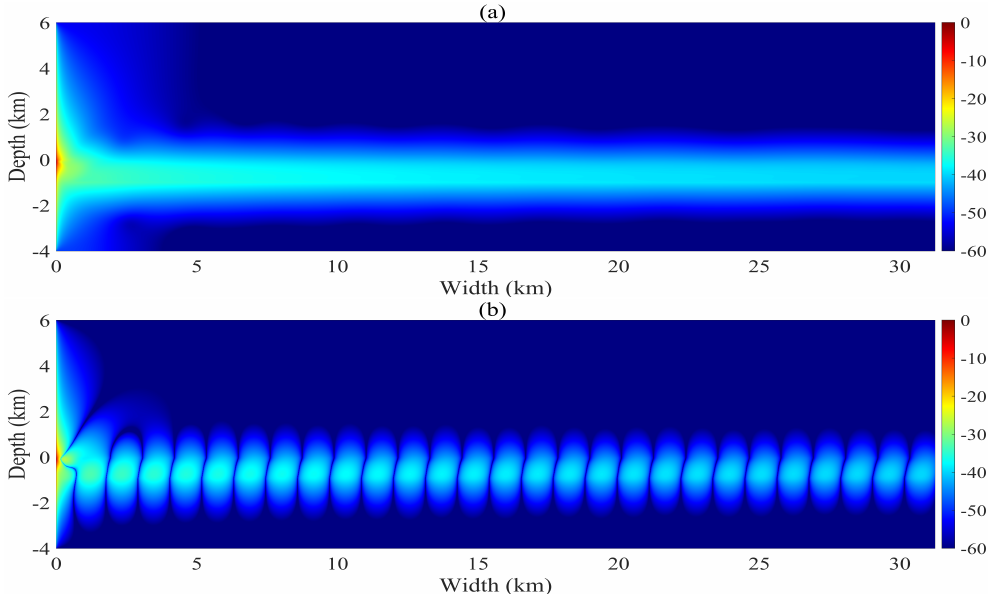
Figure 4. Distributions of induced magnetic field calculated using SEM. ( a ) Magnitude of the magnetic field. ( b ) Vertical component of the magnetic